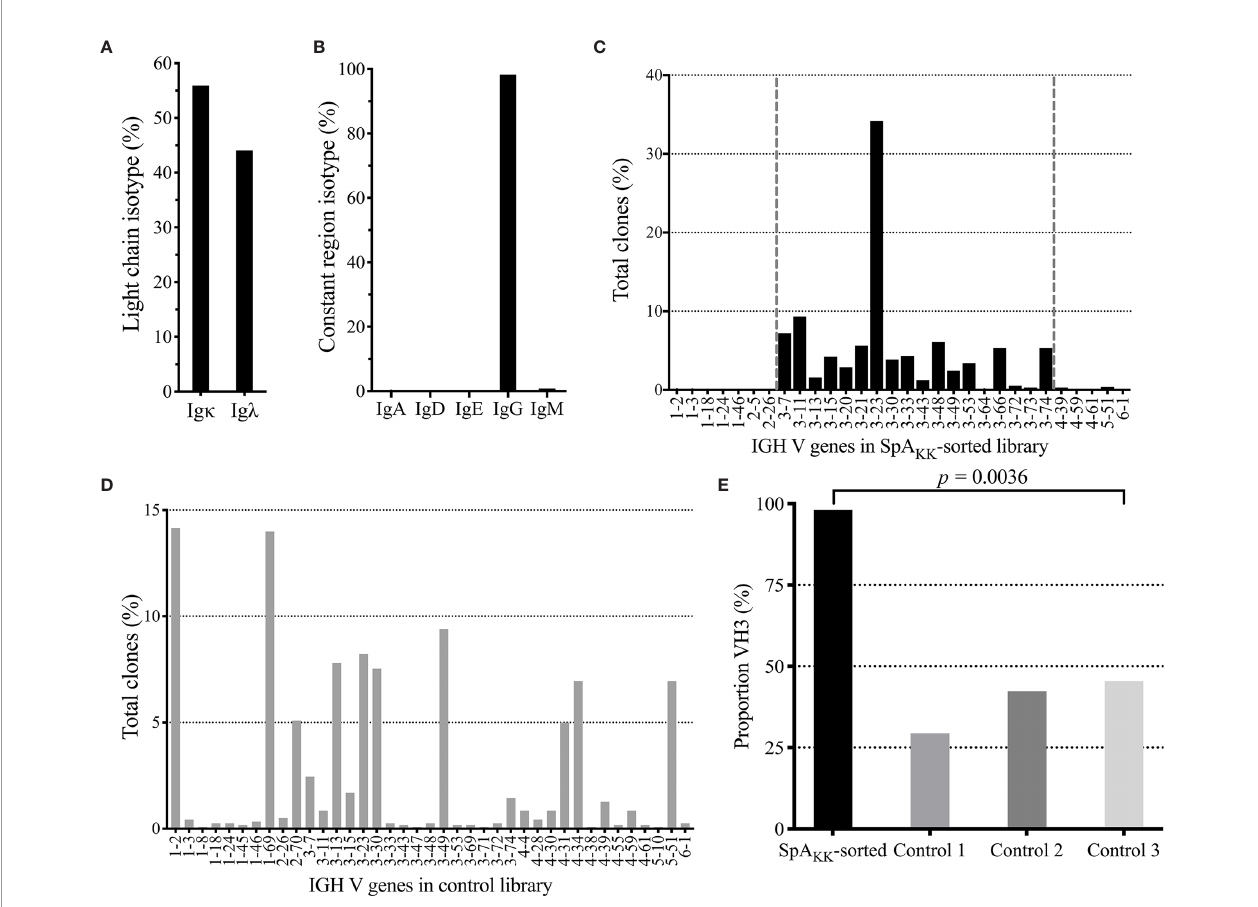
FIGURE 3 | Repertoire analysis of SpA KK -sorted memory B cells and unsorted peripheral B cells from healthy controls. (A) Isotype usage as a % of total in SpA KK - sorted repertoire. (B) Light chain usage as a % of total in SpA KK -sorted repertoire. (C) Gene usage as % of total clones identi fi ed in sequenced SpA KK -sorted repertoire. Clones mapped to the VH3 gene family are highlighted between the two vertical dashed lines. (D) Gene usage as % of total clones identi fi ed in the total memory B cell repertoire of a healthy control donor (Control 1). (E) Proportion of VH3 encoded BCR in repertoire in the SpA KK -sorted peripheral memory B cells compared to three individual healthy